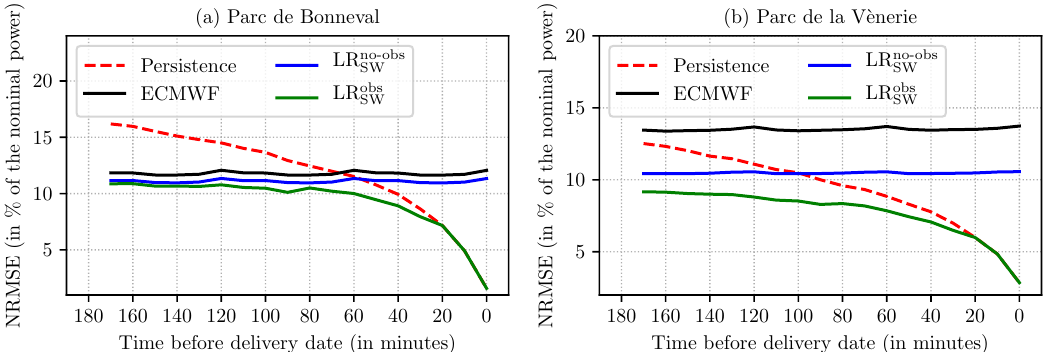
Figure 5. Forecasting errors for several forecast model as a function of lead time to delivery. Results for ECMWF, LR obs and LR no-obs nowcasts as well as persistence are shown. The models are evaluated SW SW against persistence (red dashed line). Results for Parc de Bonneval ( a ) and for Parc de la Vènerie ( b ) are shown. The x -axis displays the time before the delivery date: x = 40 means that the models are launched 40 min before the delivery